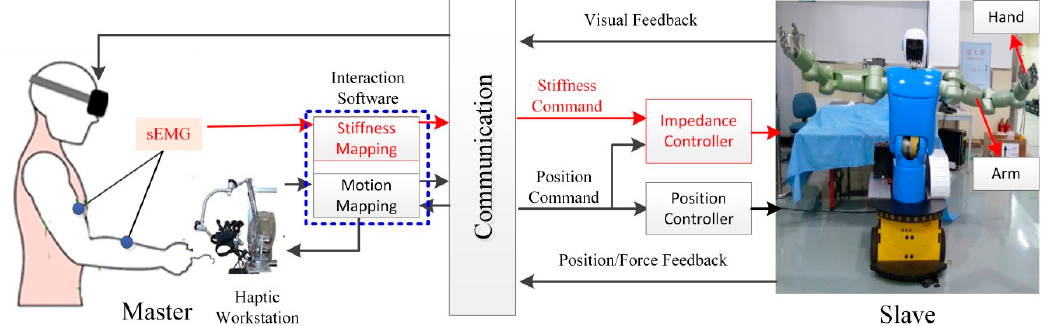
Figure 1. Schematic diagram of the hybrid mapping method for teleoperation system.